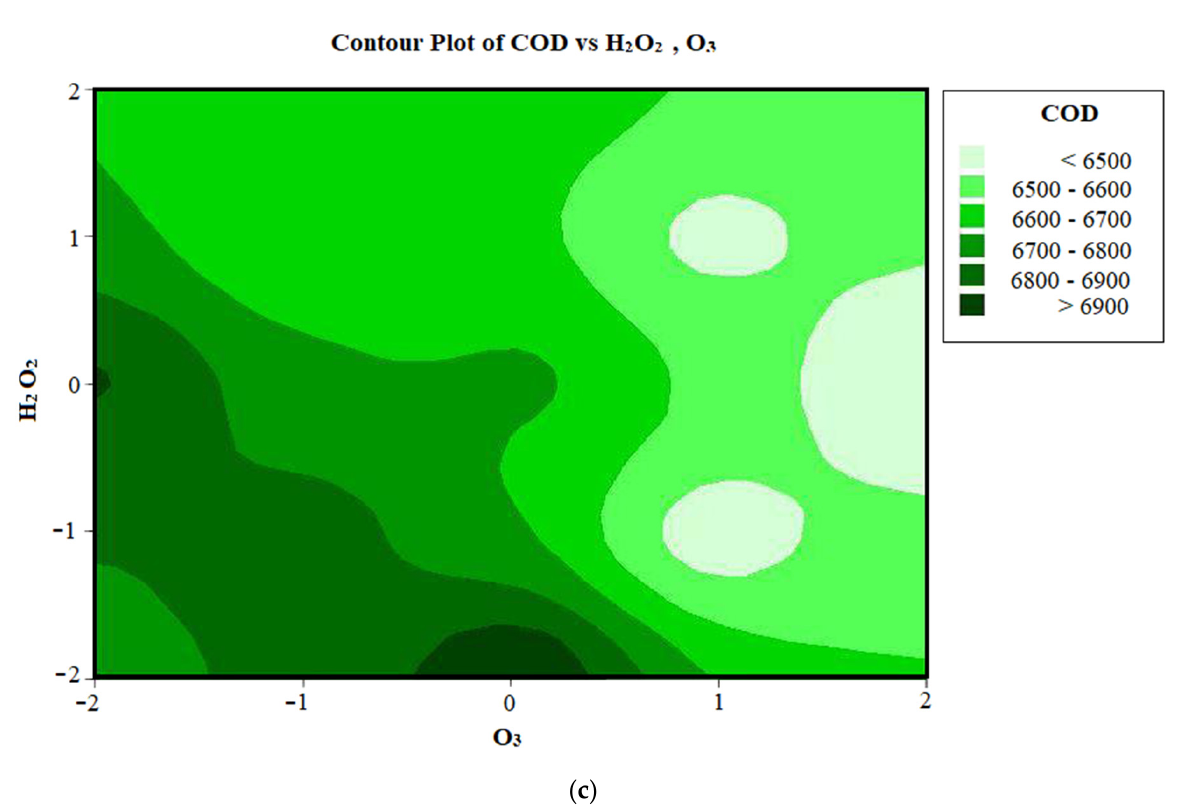
Figure 6. The contour plots showing the reduction of COD in the effluent after the AOP treatment, when ( a ) O 3 and UV change ( b ) H 2 O 2 and UV change ( c ) H 2 O 2 and O 3 change. Table 5. The optimized values defined for